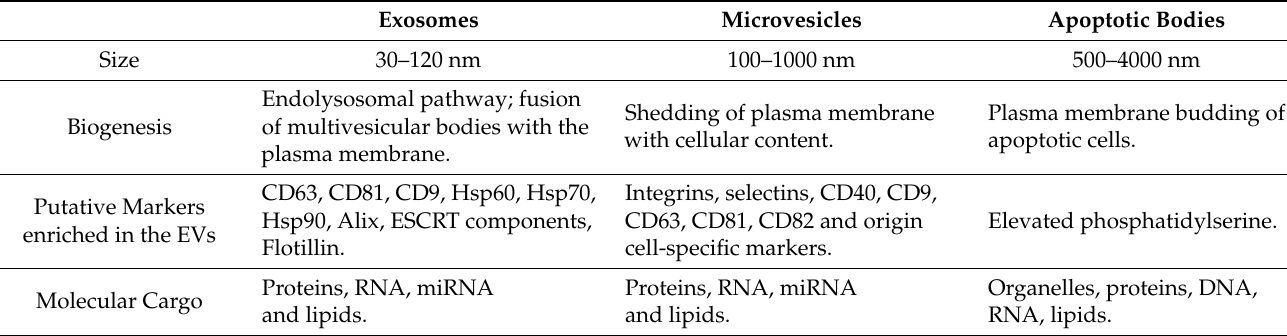
Table 1. Characteristics of different types of extracellular